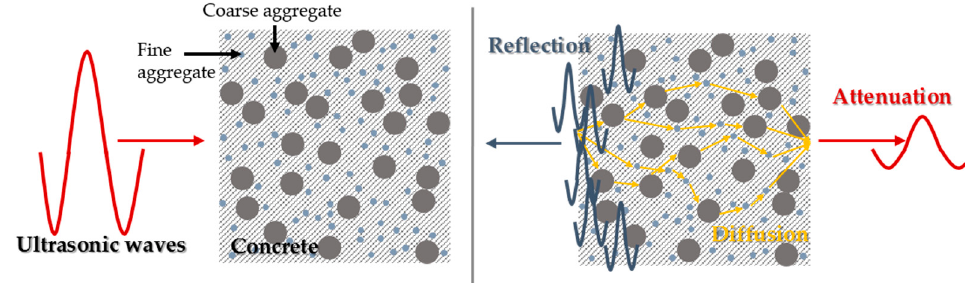
Figure 4. Diffusion of ultrasound in concrete.